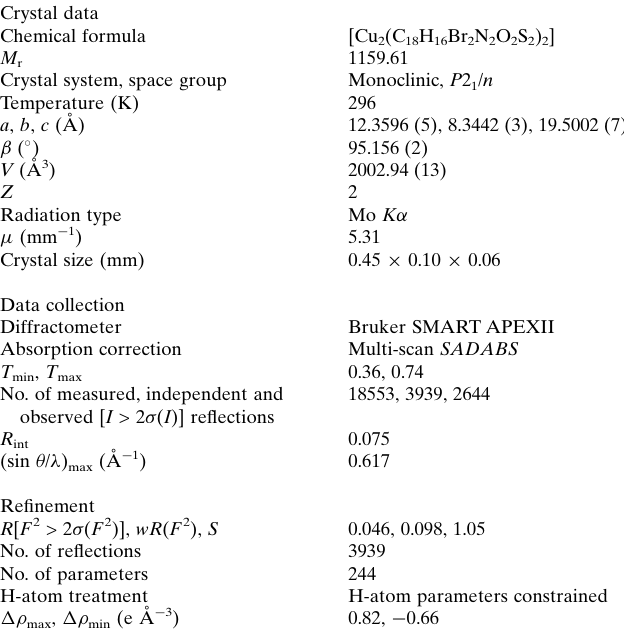
Table 1 Experimental details. Crystal data Chemical